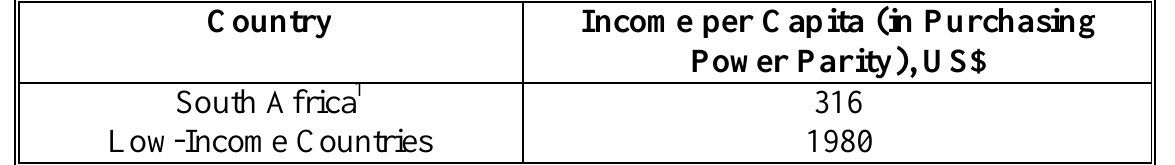
Power Parity), US$ 316